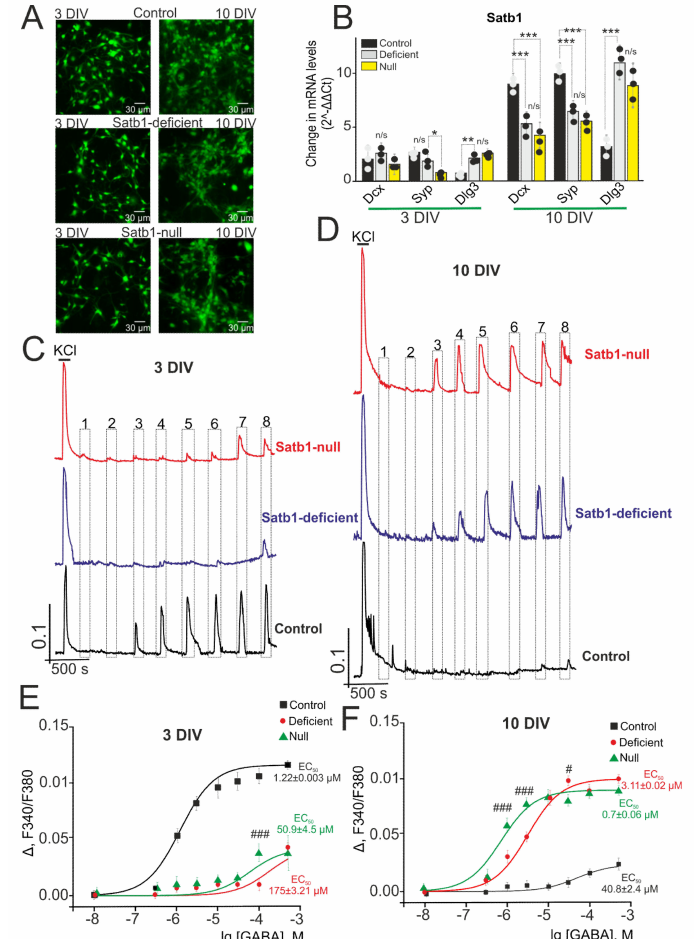
Figure 7. The effect of deletion in the transcription factor Satb1 on Ca 2+ -signals from cortical immature and mature neurons in response to activation of GABA receptors. ( A )—morphology of a cortical cell culture obtained from mice with a deletion of the transcription factor Satb1 during cultivation in vitro. The cells are loaded with the Calcein AM probe. ( B ) changes in the expression of genes encoding developmental markers during culturing of cortical cells obtained from mice with a Satb1 deletion in comparison with the control group (Satb1 +/+ * Nex Cre/+ ). Differences in the expression of all genes between 3 DIV and 10 DIV are significant at p < 0.001 (***). Significance between groups means n/s— p > 0.05, *— p < 0.05, ** p < 0.01, and *** p < 0.001. ( C , D )—application of enhancing concentrations of GABA-receptors activator, γ -aminobutyric acid (GABA) to the neurons of brain cortex isolated from the Satb1 knockout mice on the 3 ( C ) and 10 ( D ) day in vitro. ( E , F ) dependence of the Ca 2+ -responses amplitude on GABA concentration in the cultured cortical neurons from Satb1 knockout mice in the third ( E ) and tenth ( F ) day of cultivation. GABA concentrations are specified with horizontal lines accompanied with correspondent cyphers: 1–0.01, 2–0.3, 3–1, 4–3, 5–10, 6–30, 7–100, 8–500 µ M. For each concentration, average data are represented, obtained from several hundreds of neurons in 5 independent experiments ± SEM. For panels ( C , D ), averaged Ca 2+ -responses for neurons from individual experiments are represented. For panels ( C , D ), we analyzed 200 cells ( n = 200) in each experiment. For panels ( E , F ), every experiment was repeated five times ( n = 5) using cell cultures from separate passages. Statistical analyses were performed by two-way ANOVA, followed by Sidak’s multiple comparison test. Differences between groups Satb1-deficient, Satb1-null compared with control (Satb1 +/+ * Nex Cre/+ ) for panels ( E , F ) are significant *** p < 0.001 (not indicated), # p < 0.01, and ### p < 0.001 comparing Satb1-deficient group with Satb1-null group; in other cases, comparisons of Satb1-deficient vs. Satb1-null—are not significant (not